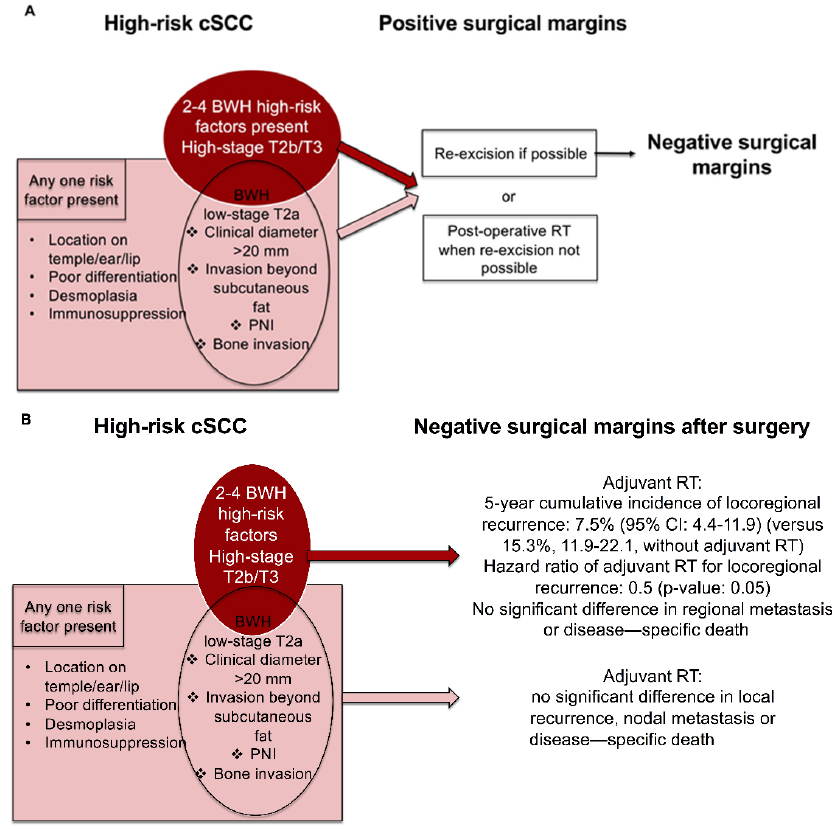
Figure 2. ( A ) Management of high-risk cSCC with positive surgical margins based on current guide- lines. ( B ) Results from recently published studies on the use of adjuvant RT after surgery of high-risk cSCC with negative (clear) surgical margins [44,46–50].